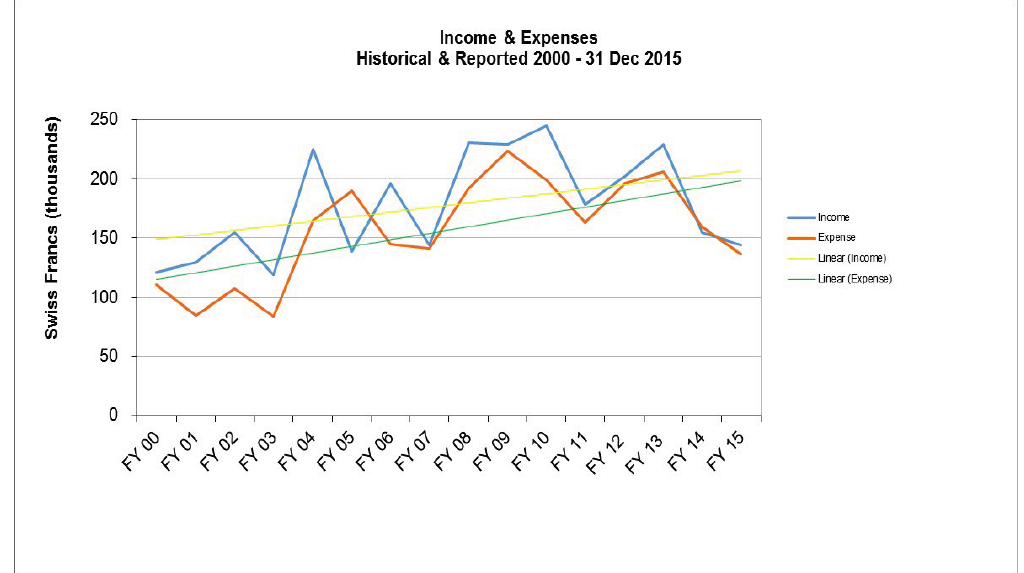
Figure 1: ISPRS income and expenditure, 2000 to